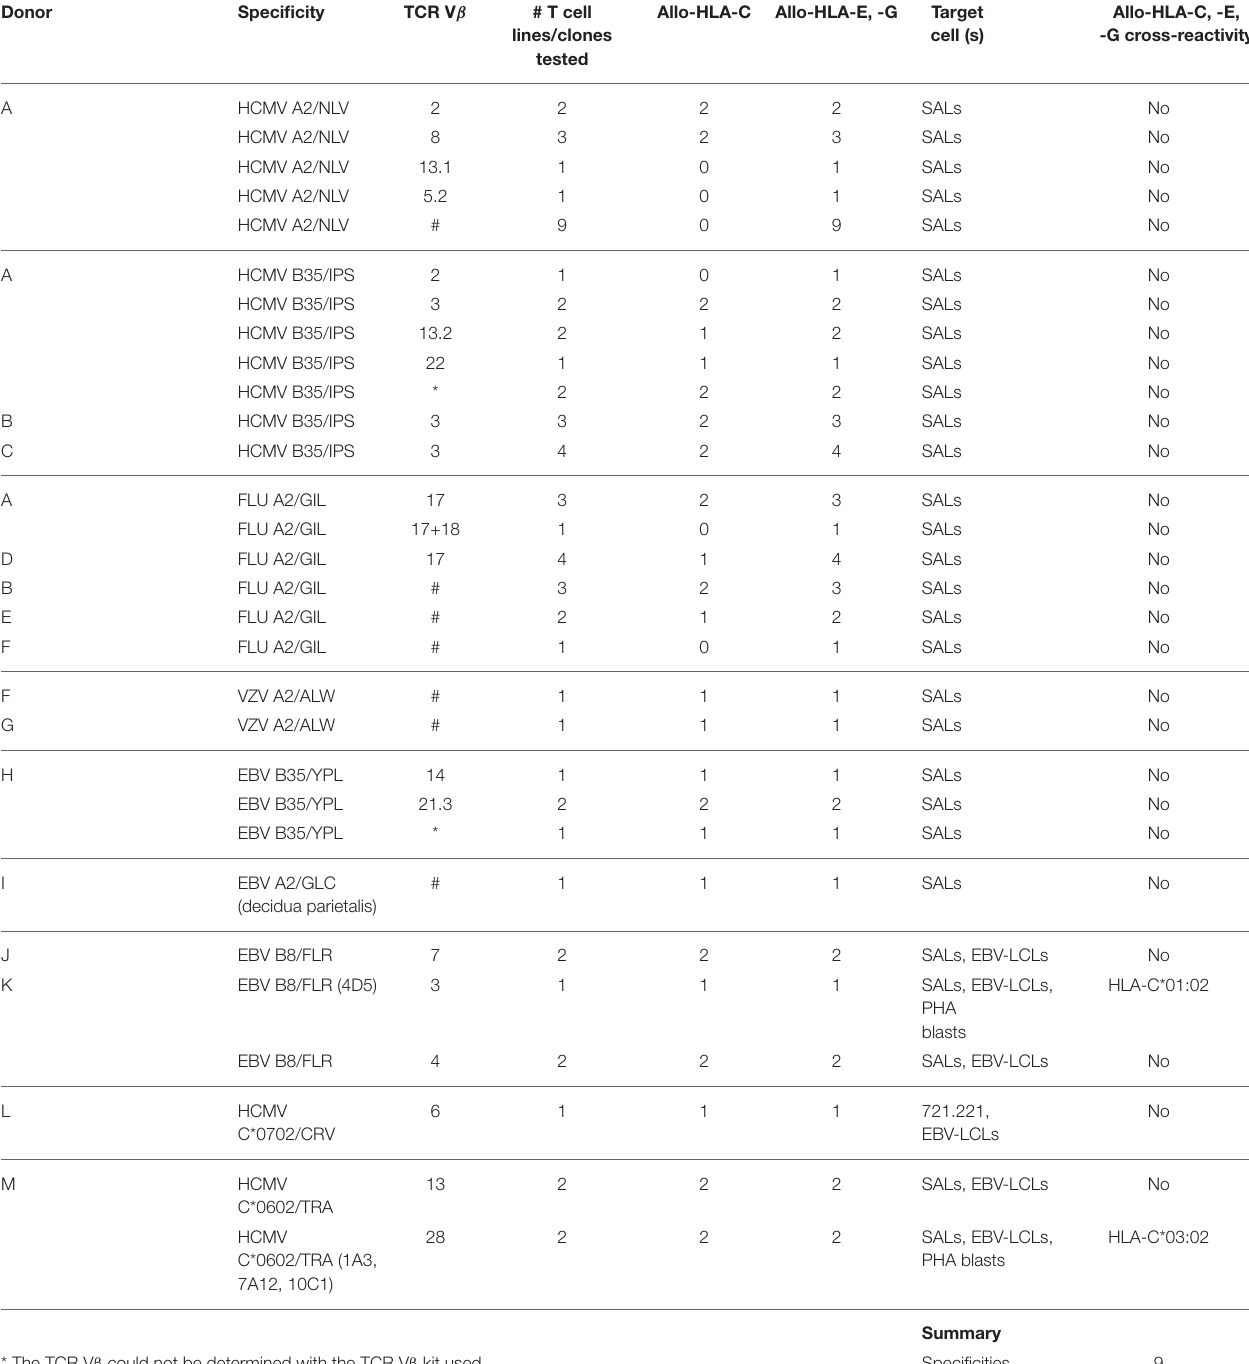
TABLE 2 | Alloreactivity of virus-specific CD8 + T cell lines and clones against HLA-C, -E, and -G.